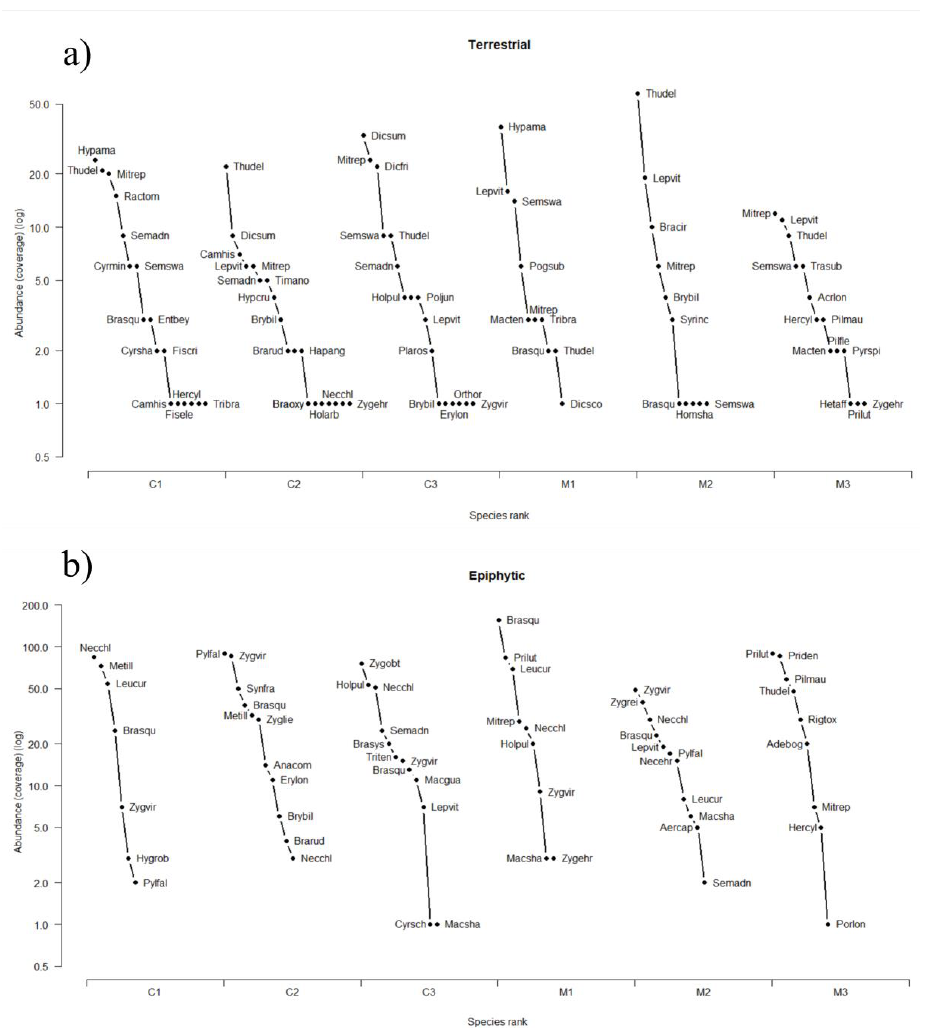
Figure 3. Rank-abundance curves of terrestrial ( a ) and epiphytic ( b ) mosses for each site, in managed and conservation forests. The acronyms correspond to the names of the species in Appendix A Table A1. Forests 2021 , 12 , x FOR PEER REVIEW